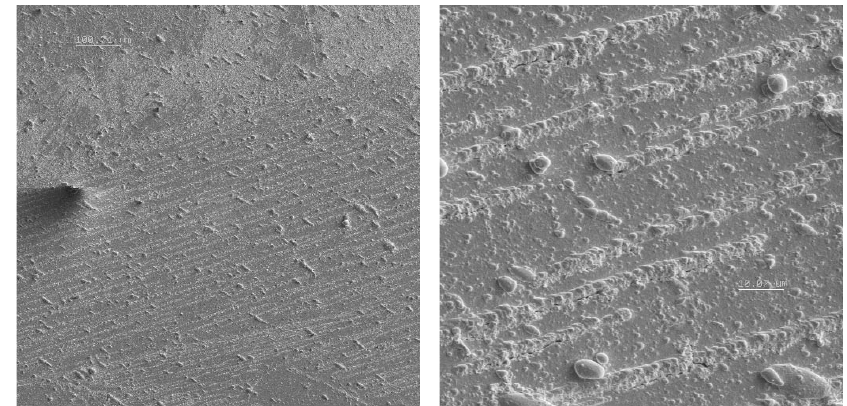
FIG. 19. Fatigue slip bands on a particular crystal grain in the area of maximum tempera- ture rise. The picture on the right is a close-up of these slip bands in which some microcracks are evident at the base of the slip bands. The scale is 100 : 7 (cid:3) m on the left and 10 : 1 (cid:3) m on the